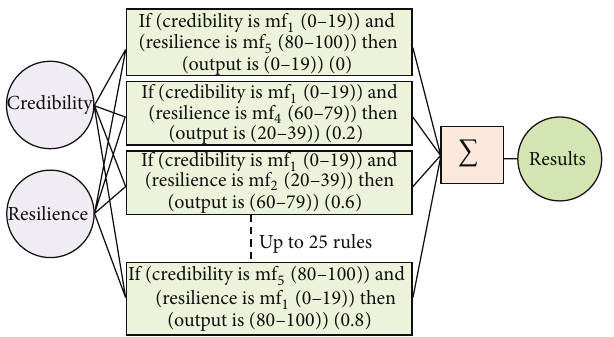
Figure 4: Proposed fuzzy rules model.